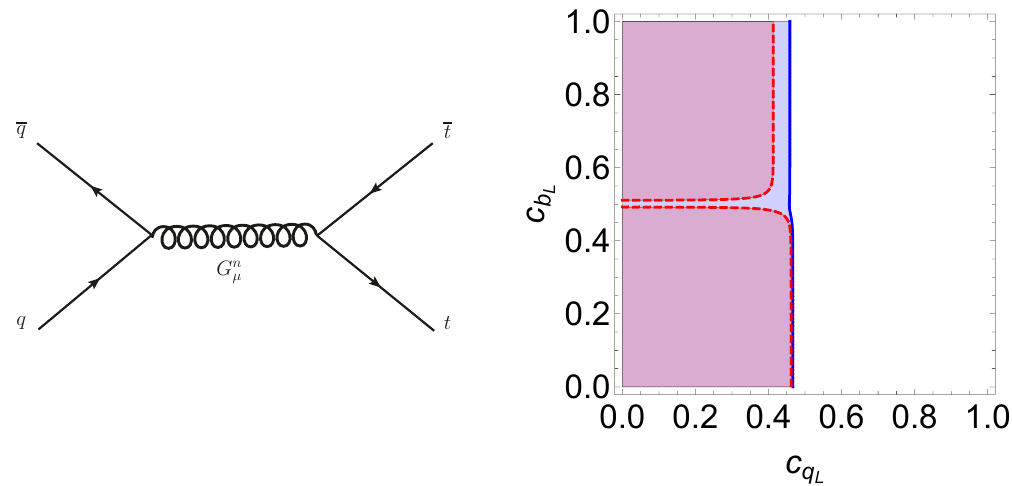
Figure 11 . Left panel: diagrams contributing to the process (cid:27) ( pp exclusion in the plane ( c q decaying into t (cid:22) t . We have used c q